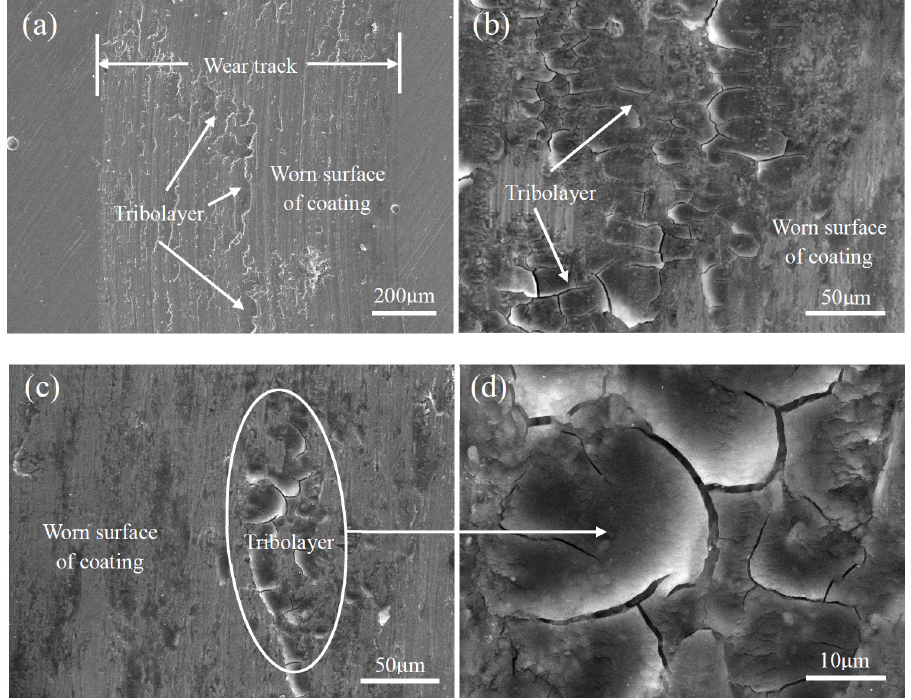
Figure 12. Typical morphology of ( a ) the wear track, ( b , c ) the tribolayer on the worn surface of the coating, and ( d ) the microtopography of the tribolayer.